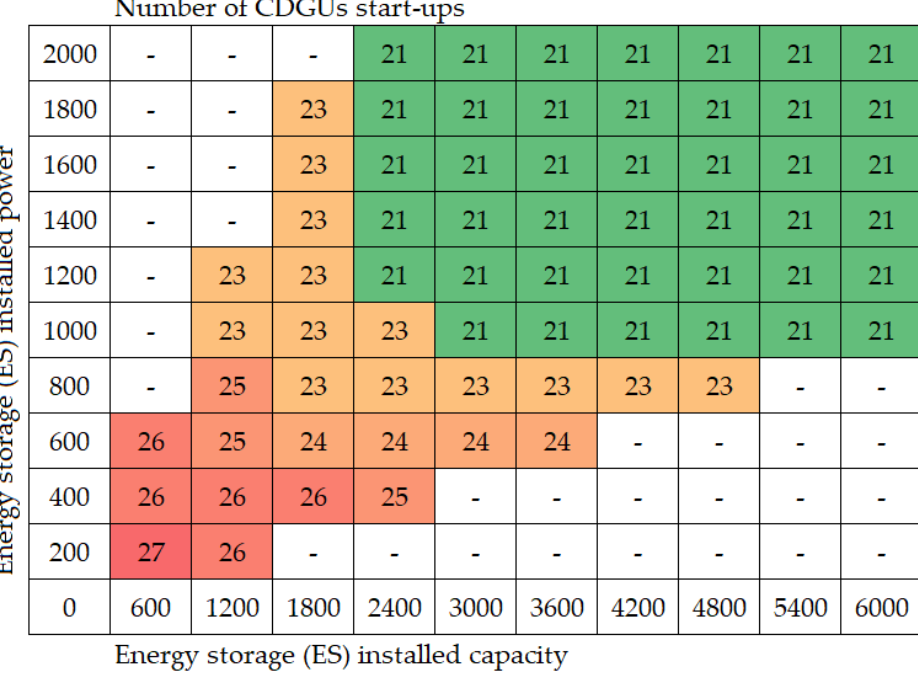
Figure 10. Impact of energy storage (ES) rated parameters on the number of CDGUs start-ups.